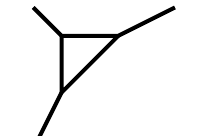
Figure 15 . A 5-brane web for the E 0 theory.